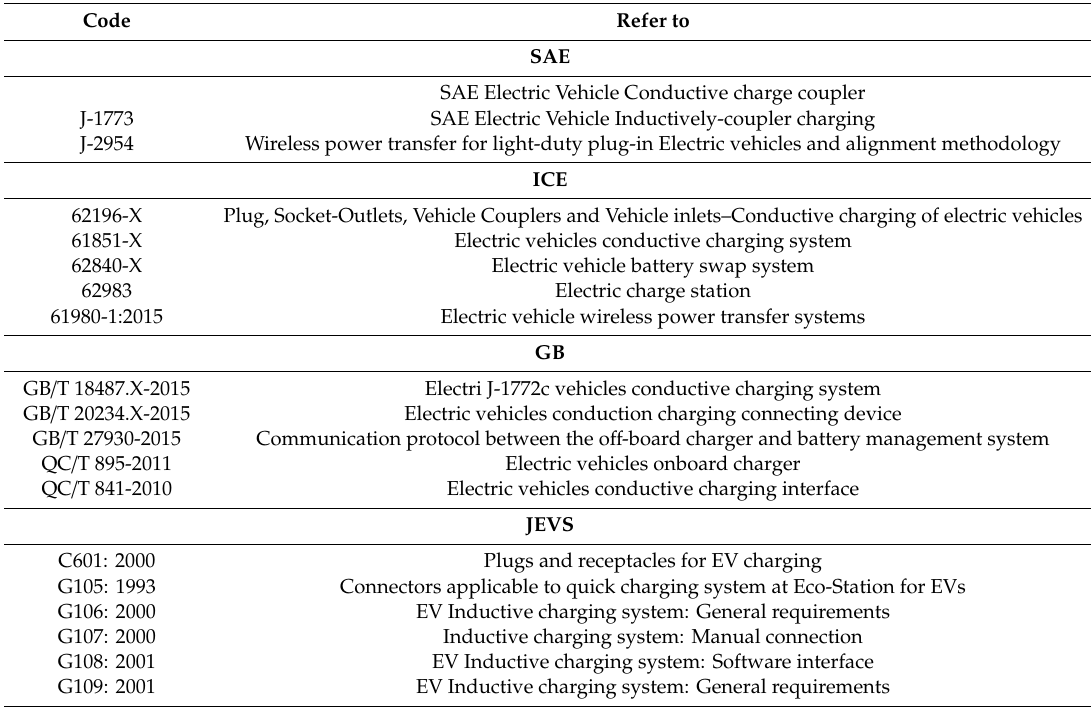
Table 2. Charging standards based on SAE, ICE, GB, and